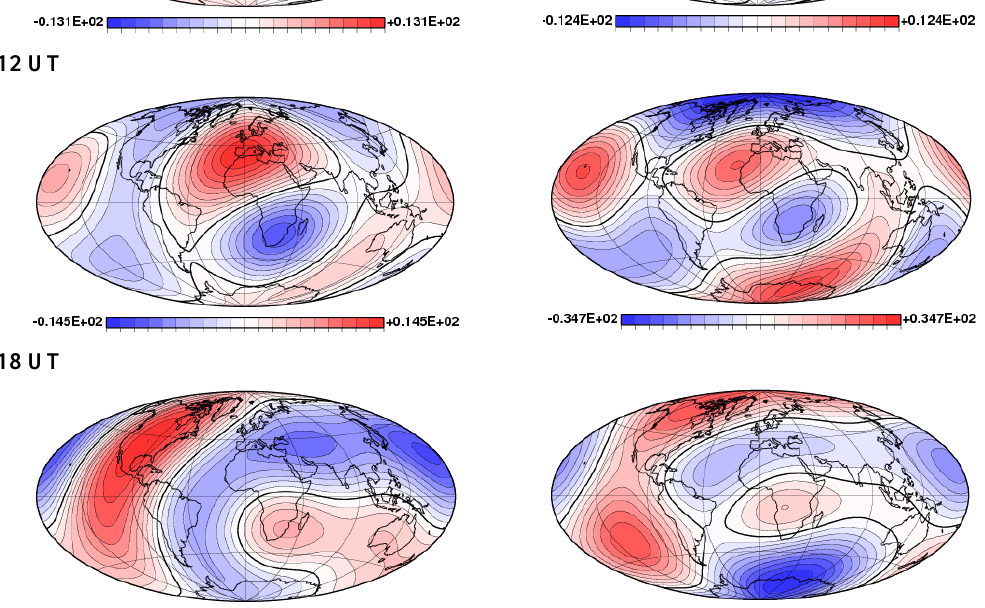
ical harmonic degree n = 1 (Fig. 5), the diurnal variation maps basically showed a dipolar structure divided into ar- eas of strong (red) and weak (blue) intensity lobes separated by areas of zero intensity (white). The surface field can only be described by a limited number of large-scale Gauss co- efficients. The lobes in the figure appear to be moving from right to left as the day progresses, with the model appearing to predict the data slightly. We can observe some similarities between the CM4 and the data at 06:00, 12:00 and 18:00 UT.